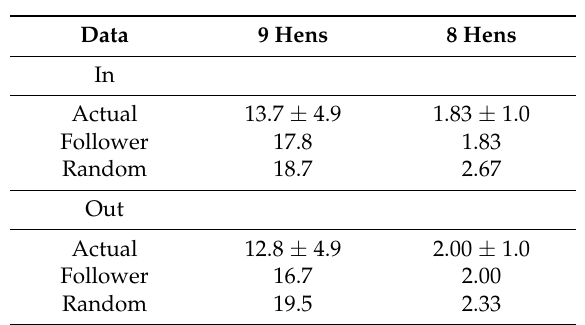
Table 2. Mean number ( ± SEM) of pairs of hens detected as possible social pairs moving in or out with a median separation distance of no more than 8 or 9 hens in between 1